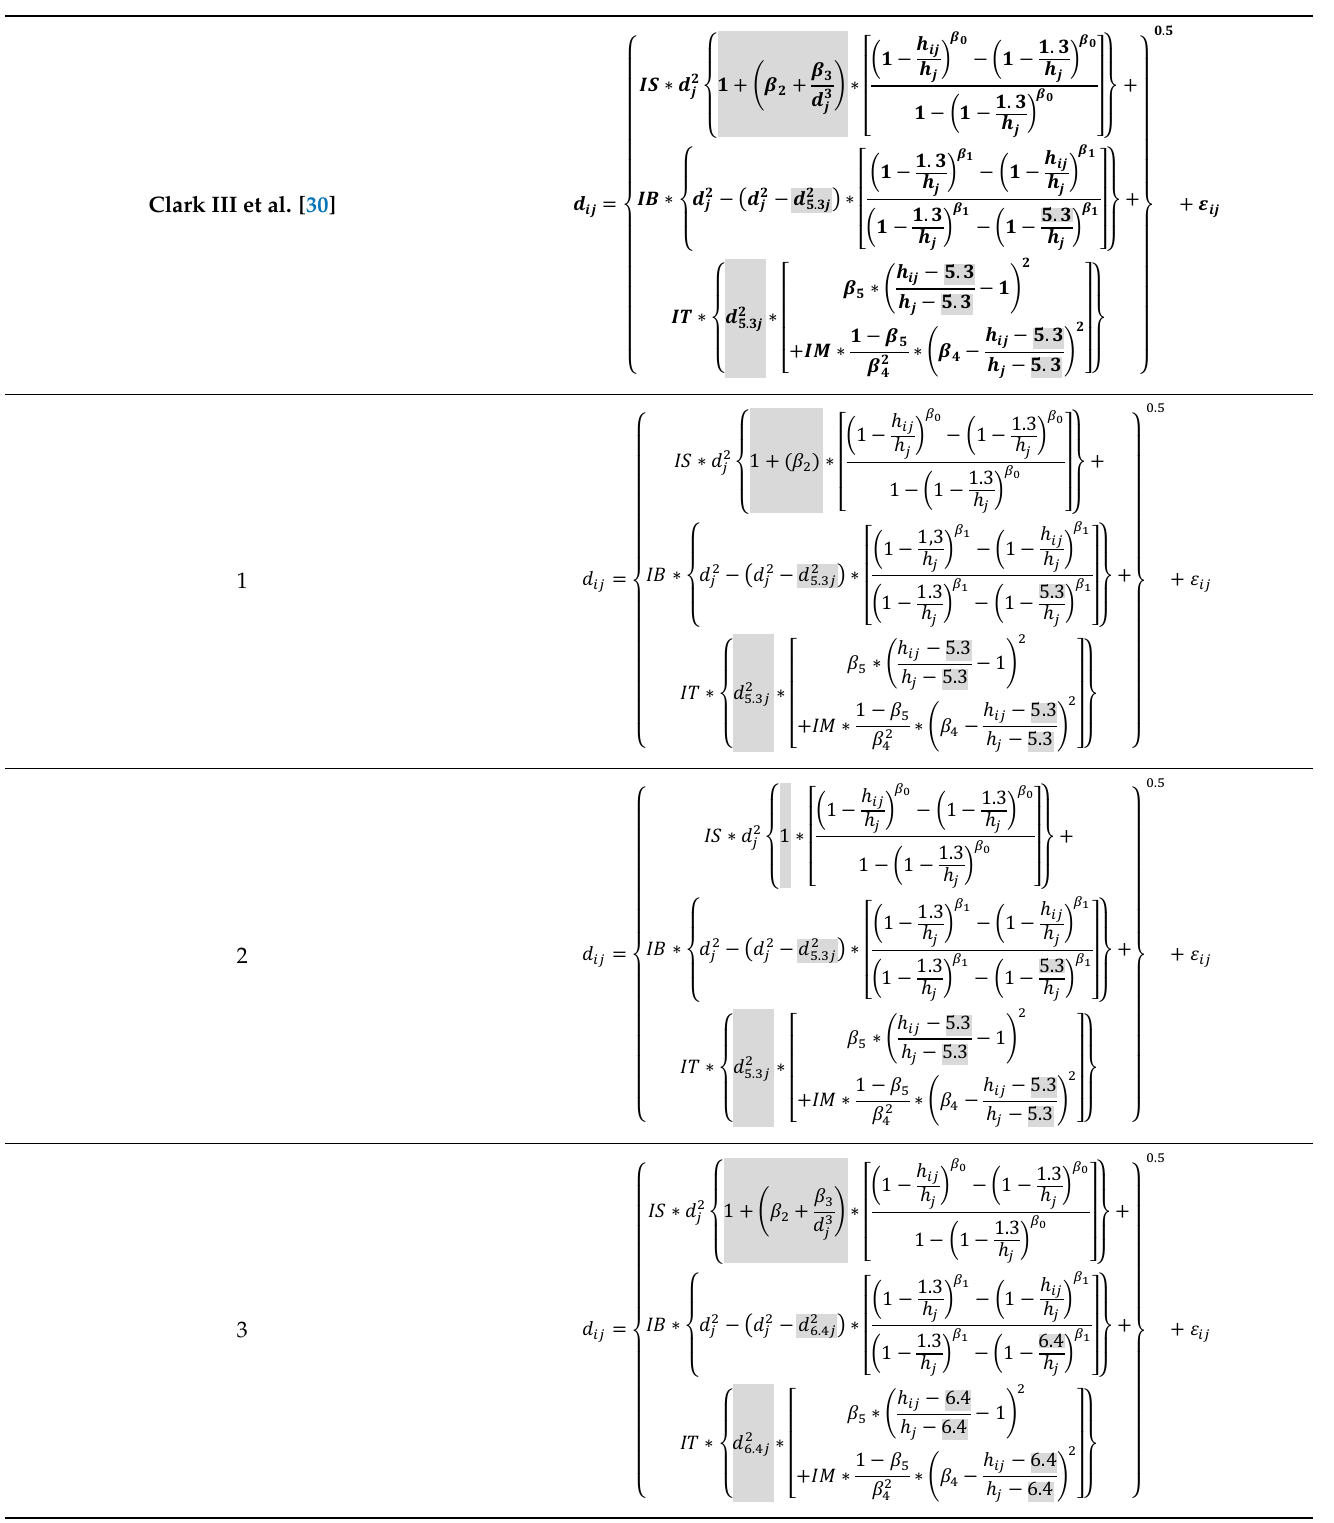
Table 4. Modifications proposed to the Clark III et al. model for the adjustment of data from Tectona grandis L.f., central-west region, Brazil.